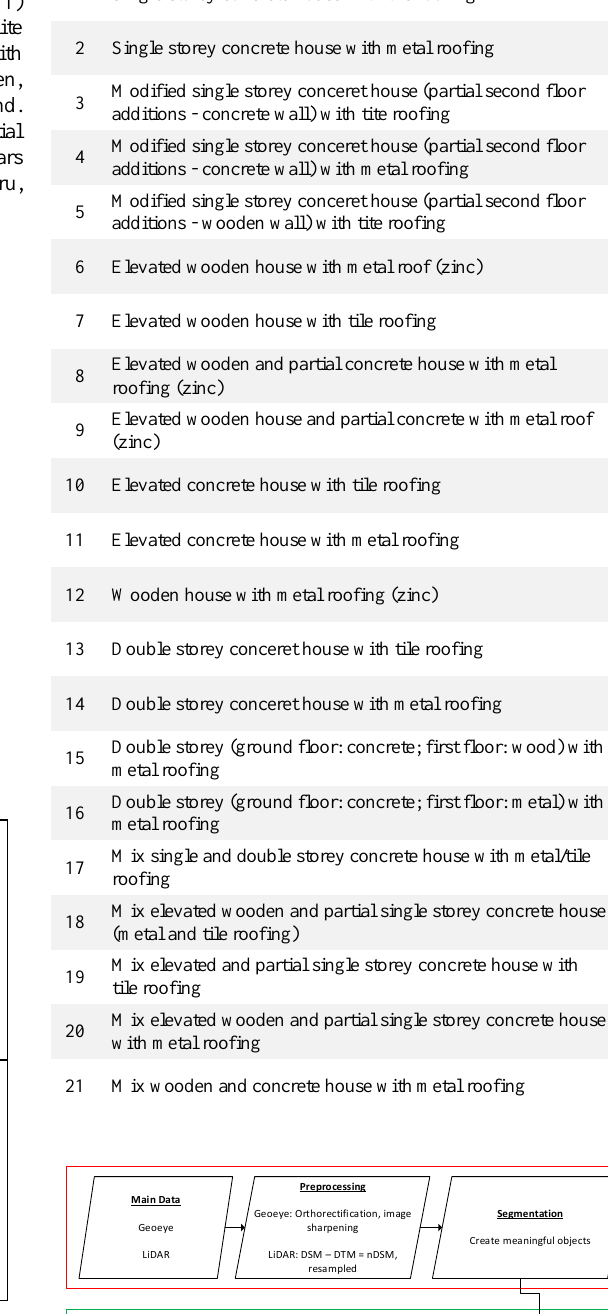
Table 1. Different type of houses.